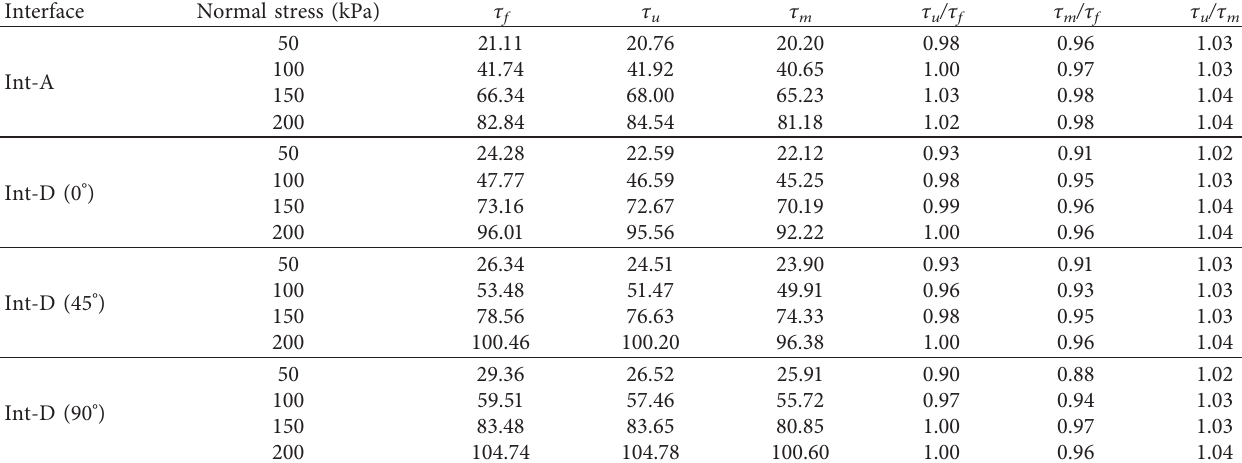
Table 5: Interface pear shear stress of the mathematical model and test (kPa).